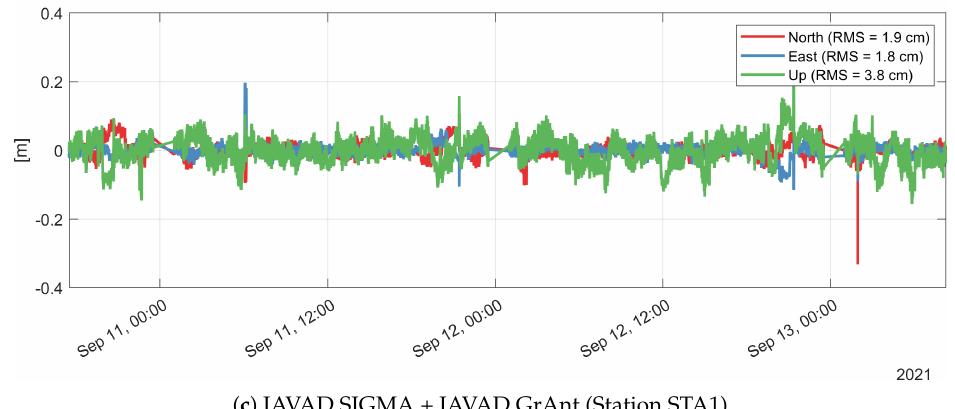
Figure 14. Session 2: results for the kinematic displacements obtained from the static experiments— ambiguity-fixed solutions computed with